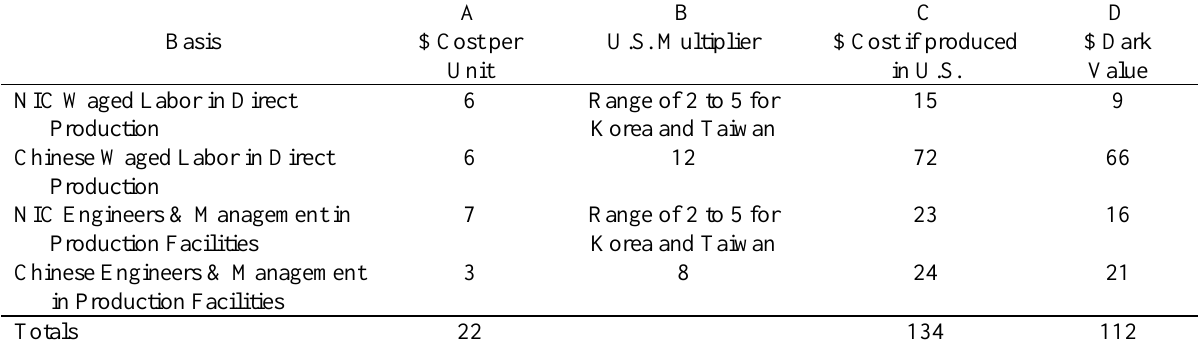
Table 7. Dark Value Extracted from Underpaid Labor in Tier 3 ( Non-Core Production of